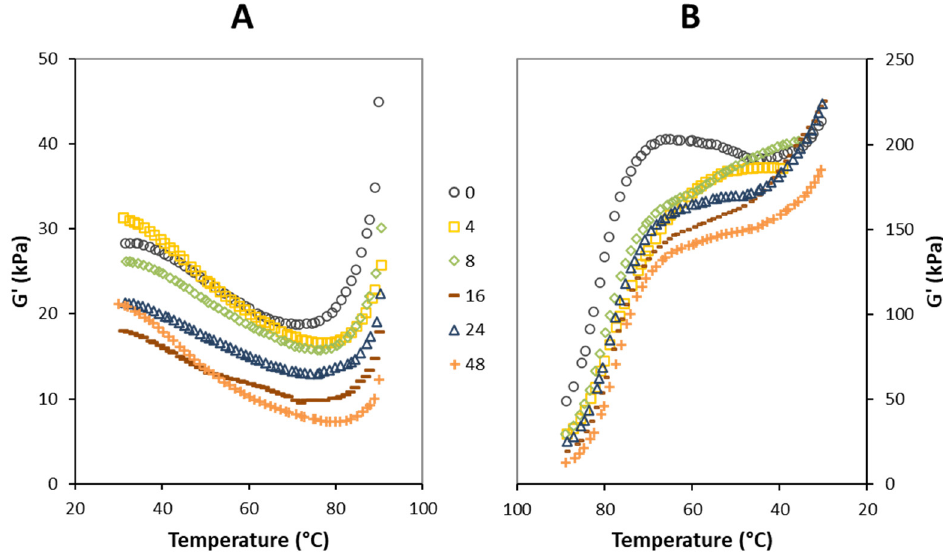
Figure 2. Elastic modulus (G’) of pizza dough at the selected leavening time during the heating ( A ) and cooling ( B ) phases. and cooling ( B )